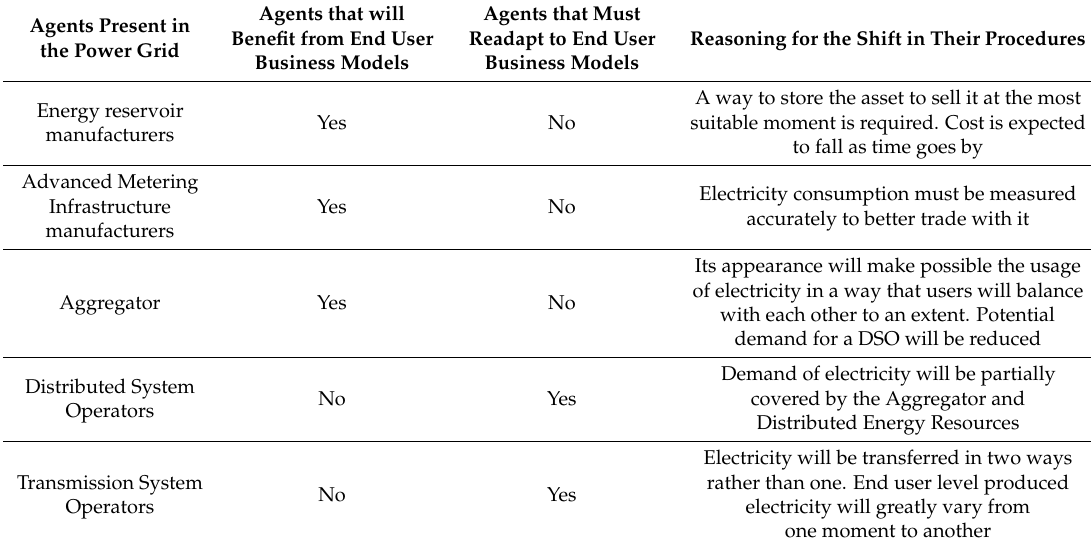
Table 4. Role shift for small scale, end user business models in the Smart